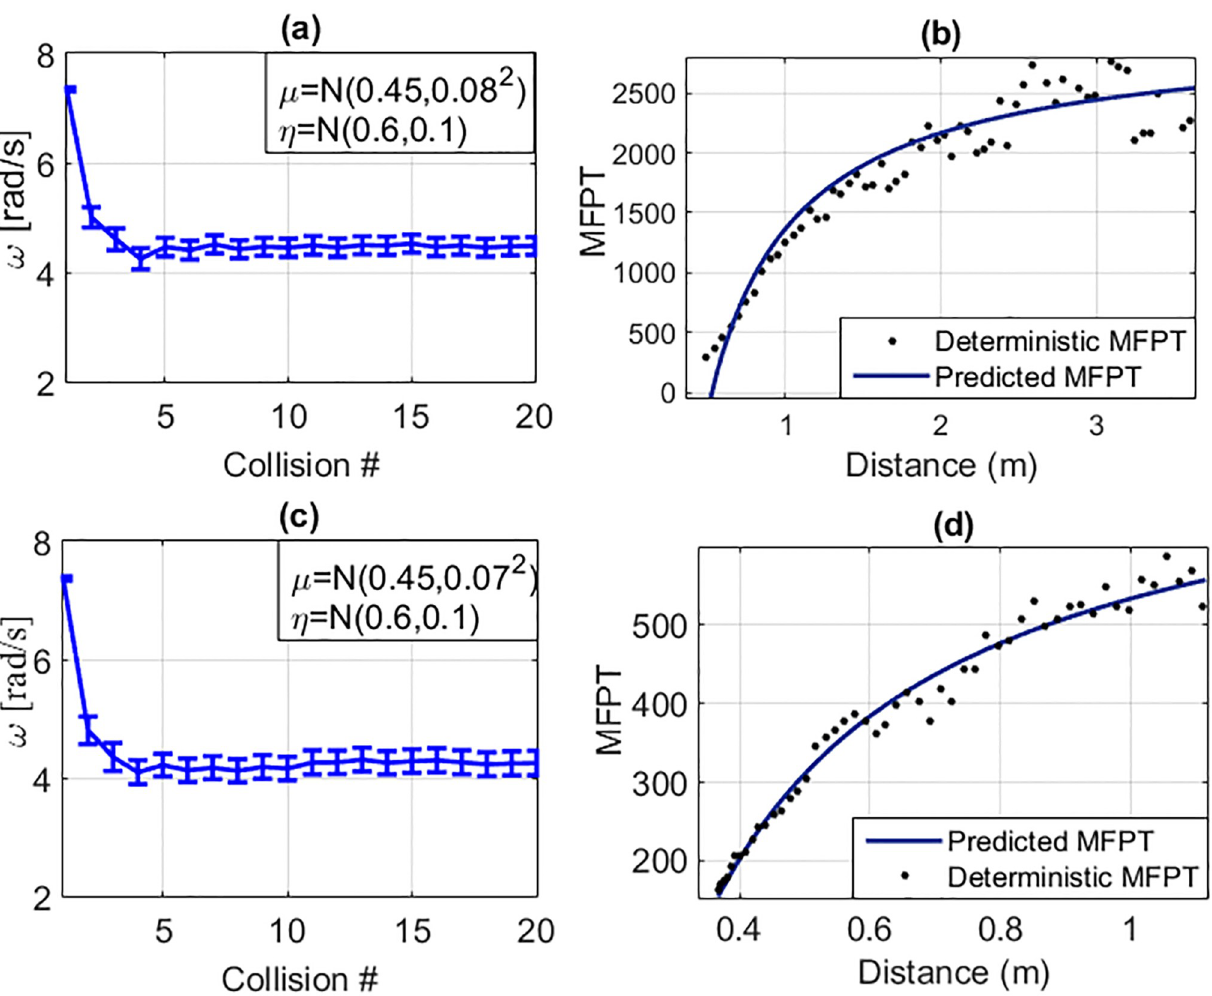
Fig 7. RW simulation (a) Scenario I: with m ¼ N ð 0 : 45 ; 0 : 08 2 Þ , Z ¼ N ð 0 : 6 ; 0 : 1 Þ . The ω profile’s mean and standard deviation for the 10,000 simulations. (b) Comparison of the numerical MFPT (obtained through Monte-Carlo simulations) to the prediction. (c) Scenario II: with m ¼ N ð 0 : 45 ; 0 : 07 2 Þ , Z ¼ N ð 0 : 6 ; 0 : 1 Þ . The ω profile’s mean and standard deviation for the 10,000 simulations. (d) Comparison of the numerical MFPT (obtained through Monte-Carlo simulations) to prediction.